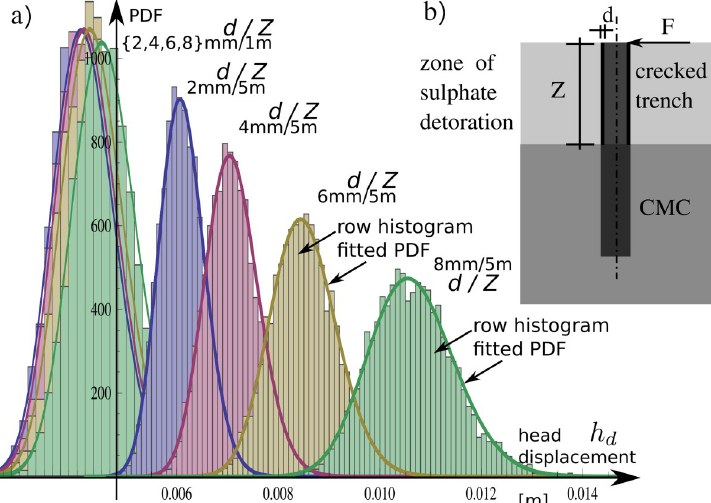
Fig 10. The selected log-normal distributions created for the results of column head horizontal displacement histograms for two combinations of analysed cases with 1- and 5-m thick fissured zones as well as for d = {2, 4, 6, 8} mm sulphate deterioration depths into the column skinned surface in each zone variant.